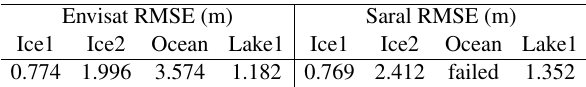
Table 1: Root mean square errors between in situ data and satel- lite altimetry for the four retrackers of both Envisat and Saral.